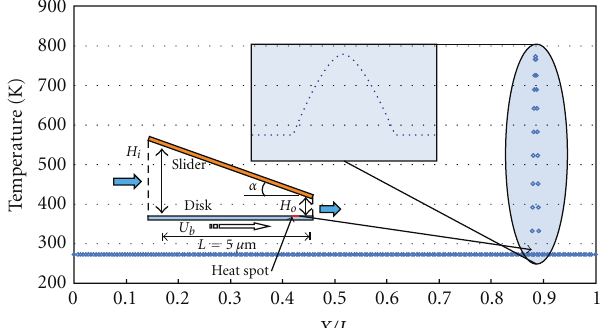
Figure 4: The temperature distribution profile with a heated spot on the disk.